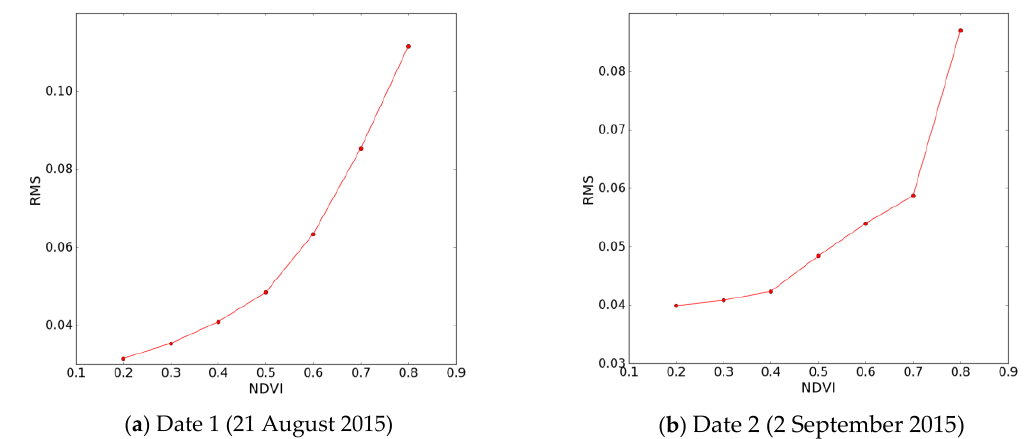
( a ) Date 1 (21 August 2015) ( b ) Date 2 (2 September 2015) Figure 14. RMS between methods 1 and 2, as a function of NDVI for date 21 August 2015 ( a ) and date 2 September 2015 ( b ).